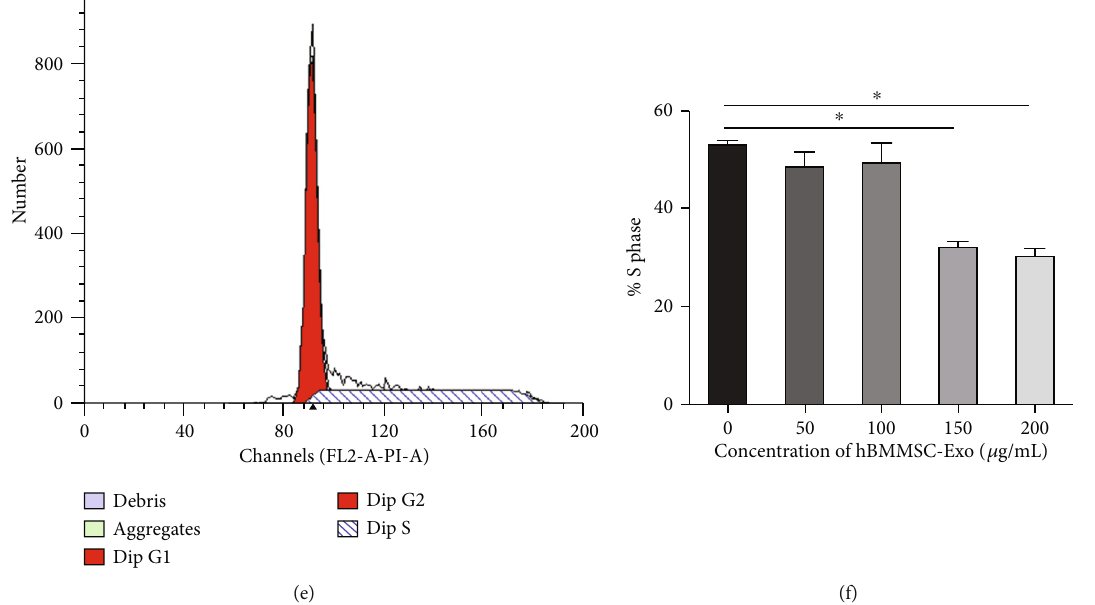
Figure 3: Bone marrow MSC-Exo arrested CML cell cycle. Cell cycle analysis was performed after K562 cells were treated with hBMMSC-Exo (0, 50, 100, 150, and 200 μ g/mL) for 48 h: (a) control group; (b) 50 μ g/mL group; (c) 100 μ g/mL group; (d) 150 μ g/mL group; (e) 200 μ g/mL group. (f) Representative cell cycle analysis of the S phase in K562 cells after hBMMSC-Exo treatment. The data were expressed as the mean ± SD of the three independent experiments. ∗ p < 0 : 05 Student ’ s t